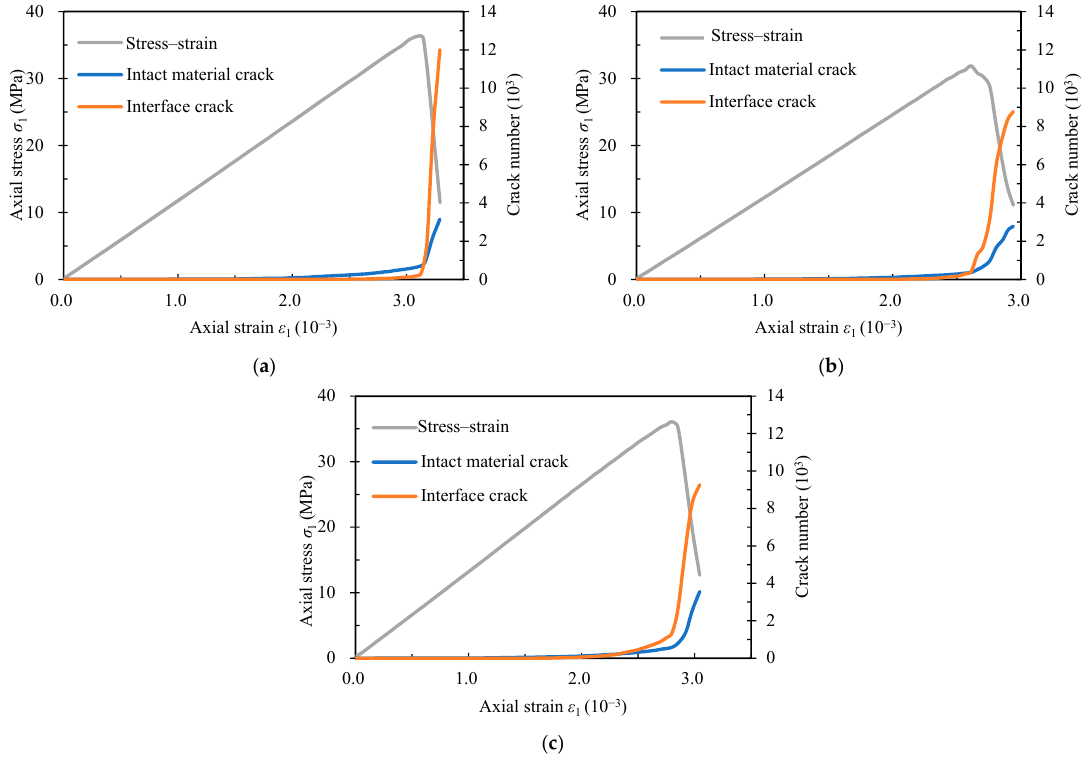
Figure 12. Crack number evolution of transversely isotropic rock models with dip angles of ( a ) α = 45°, ( b ) α = 60° and ( c ) α = 75°.